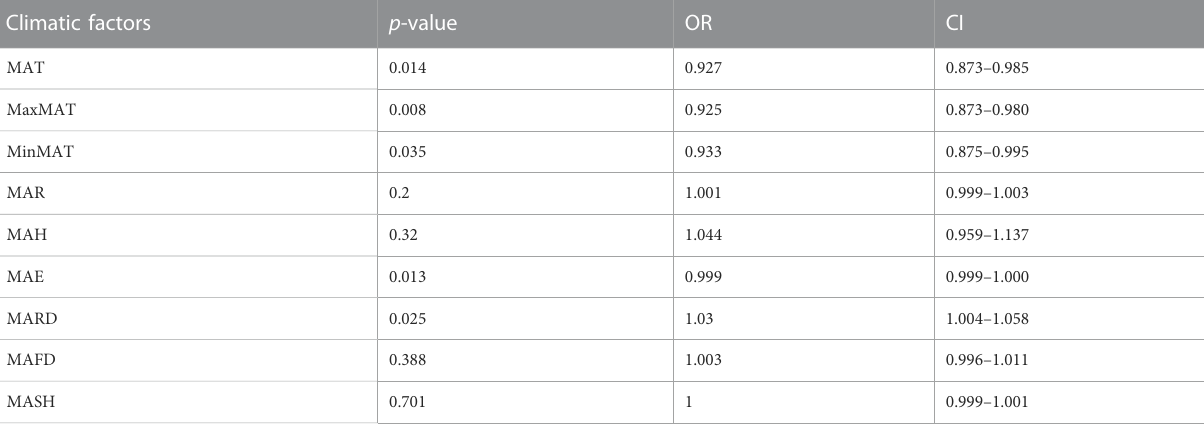
TABLE 1 Univariate analysis of the effect of climatic factors on asthma hospitalization.